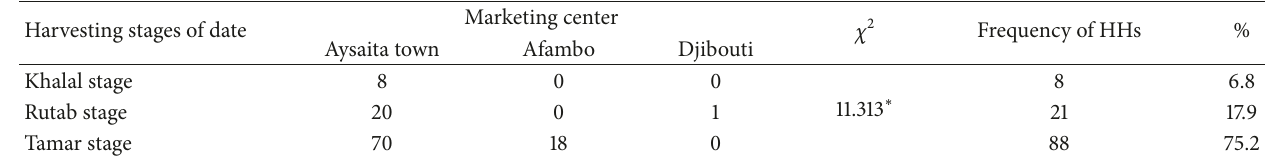
Table 6: Harvesting stages of date palm fruits and their marketing center in the study